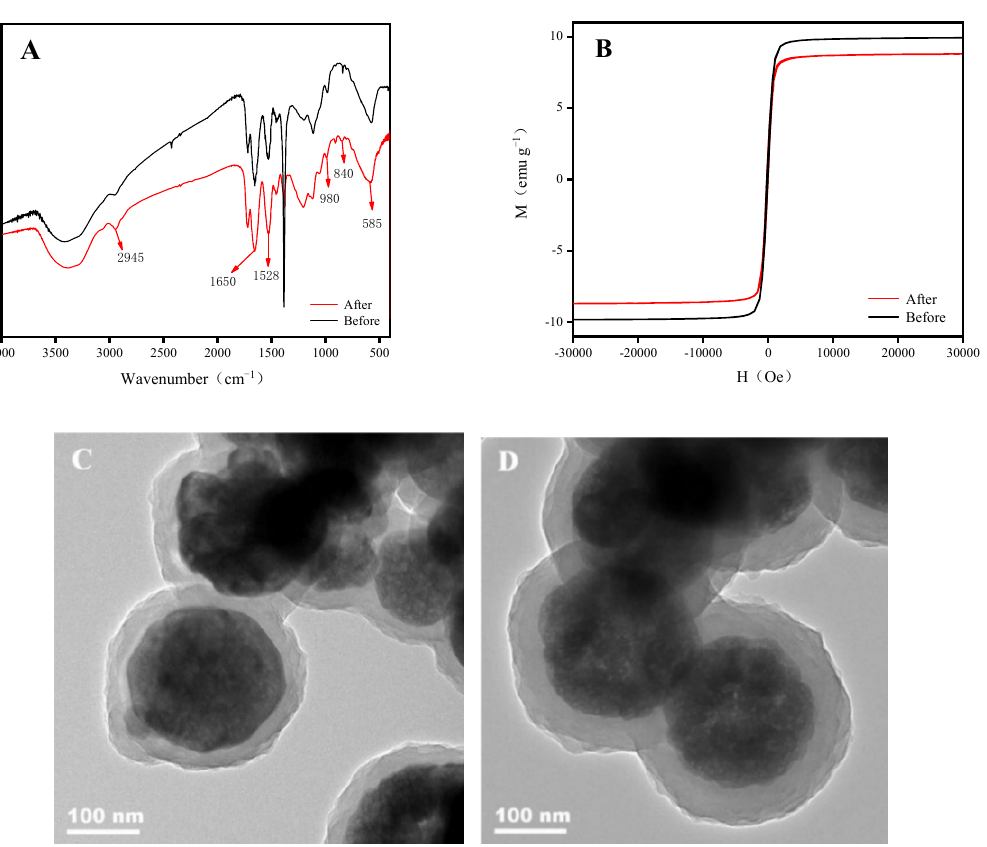
Figure 5. Fe 3 O 4 /P(GMA-MBA)-PO 4 was soaked in a HNO 3 medium with pH 4.5 for 24 h before and after: ( A ) Infrared spectra; ( B ) VSM spectrum; ( C ) TEM images taken before immersion; ( D ) TEM images after immersion .